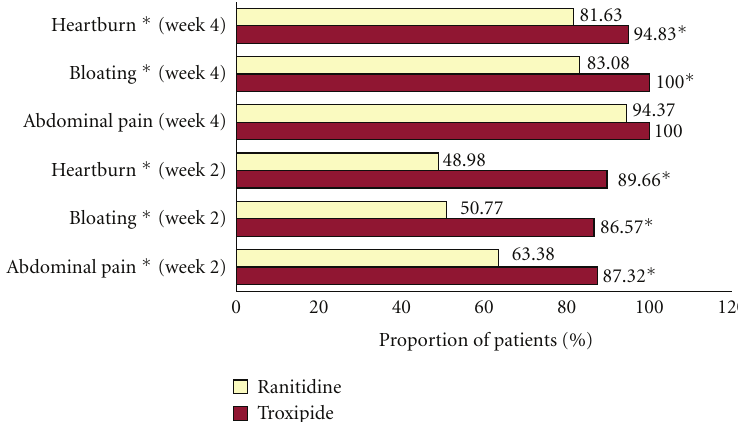
Figure 2: Clinical symptom improvement in endoscopic gastritis with Troxipide and Ranitidine. Percentage of patients at each followup period (week 2 and 4) reporting clinical symptom improvement (a reduction in the VAS score of at least 20 points from baseline to followup) for abdominal pain, bloating, and heartburn with Troxipide and Ranitidine ( ∗ P < . 05 and ∗∗ P < .